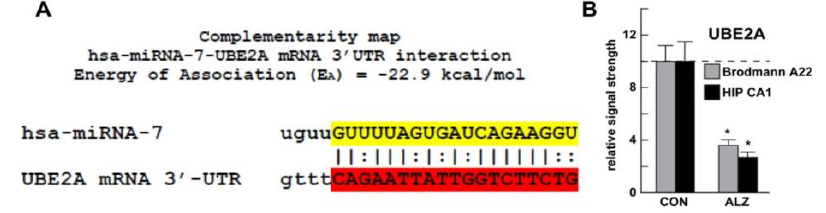
Figure 1. A strong miRNA-7-UBE2A mRNA 3’-UTR interaction. ( A ) Complimentarity map of human miRNA-7 and the UBE2A mRNA 3′-UTR—an “ | ” represents a hydrogen bond between the miRNA-7 and the UBE2A mRNA 3’-UTR and “ : ” represents a partial hydrogen bond; “seed” sequences are highlighted in yellow for miRNA-7 and in red for the UBE2A mRNA 3′-UTR; an energy of association (E A ) between the miRNA-7 and the UBE2A mRNA 3′-UTR of −22.9 kcal/mol is very favorable thermodynamically; due to a deficit in ciRS-7 there are insufficient miRNA-7 sponging effects and an